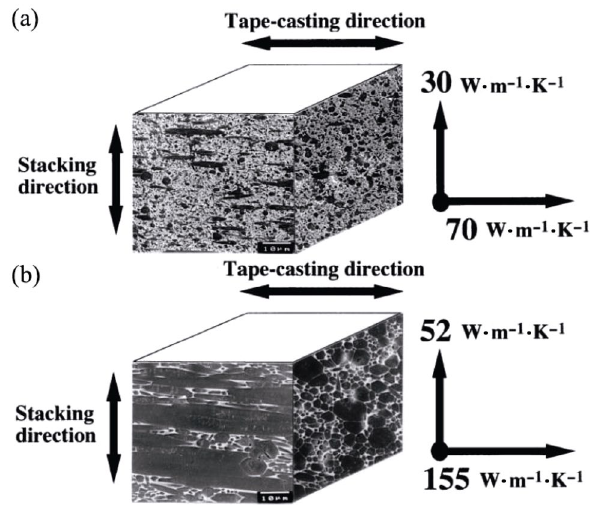
Fig. 29 Plasma-etched surface morphologies and thermal conductivities of textured Si 3 N 4 fabricated by: (a) TGG and HP; (b) TGG, HP, and HIP. Reproduced with permission from Ref. [221], © Materials Research Society